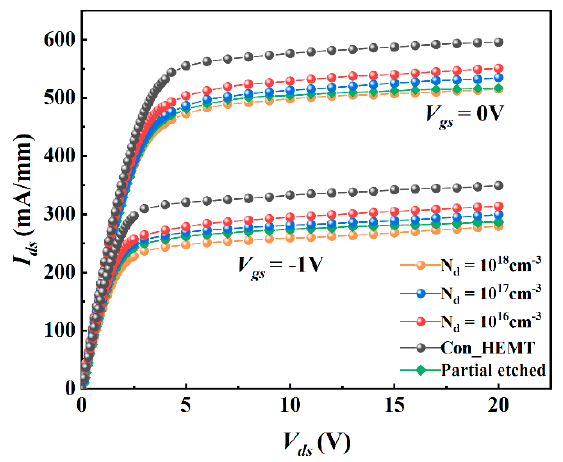
Figure 3. I ds − V ds of the proposed structure with different doping concentration.